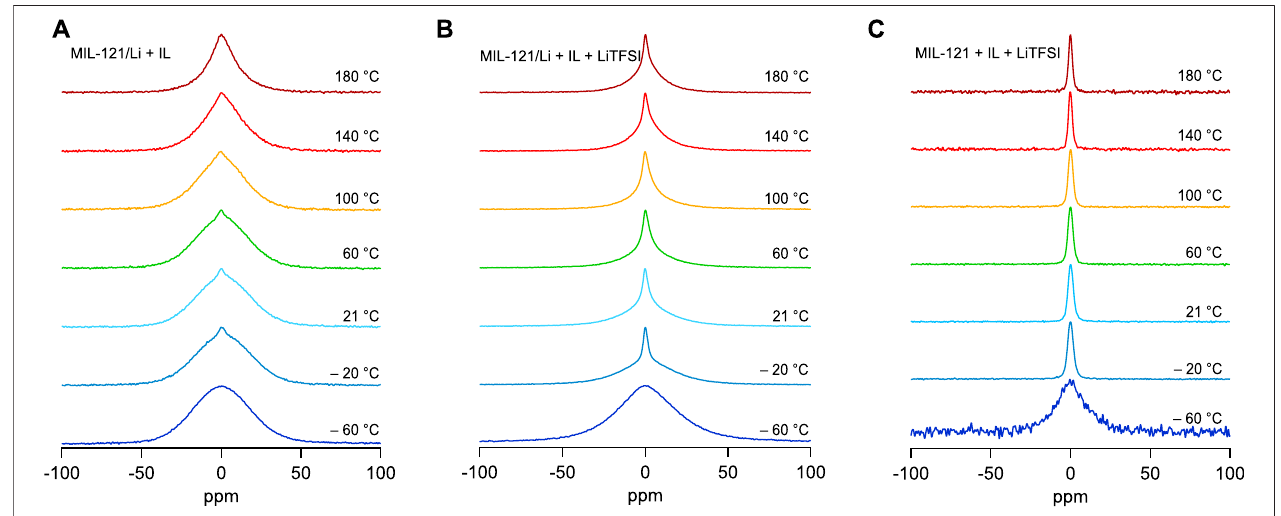
FIGURE4|(A) 7 LiNMRlinesacquiredinamagnetic fi eldstrengthB 0 (cid:1) 7 Tforwhichthe 7 LiNMRcentralresonancefrequencyis116.59MHz. (A) The 7 LiNMRline width of MIL-121/Li + IL shows little motional narrowing with increasing temperature. However, a small narrower line that can be assigned to faster jumping Li + ions is visible on top of the broad 7 Li signal. The broad line can probably be assigned to the slow jumping of Li + contained in the functionalized MOF. (B) The 7 Li NMR lines at varioustemperatureofasamplethatcontains77 wt%MIL-121/Liand23 wt%solutionof0.4 MLiTFSIinEMIM-TFSI. (C) The 7 LiNMRlinesatvarioustemperature of a sample that contains 77 wt% MIL-121 (pure activated MOF) and 23 wt% solution of 0.4 M LiTFSI in EMIM-TFSI.